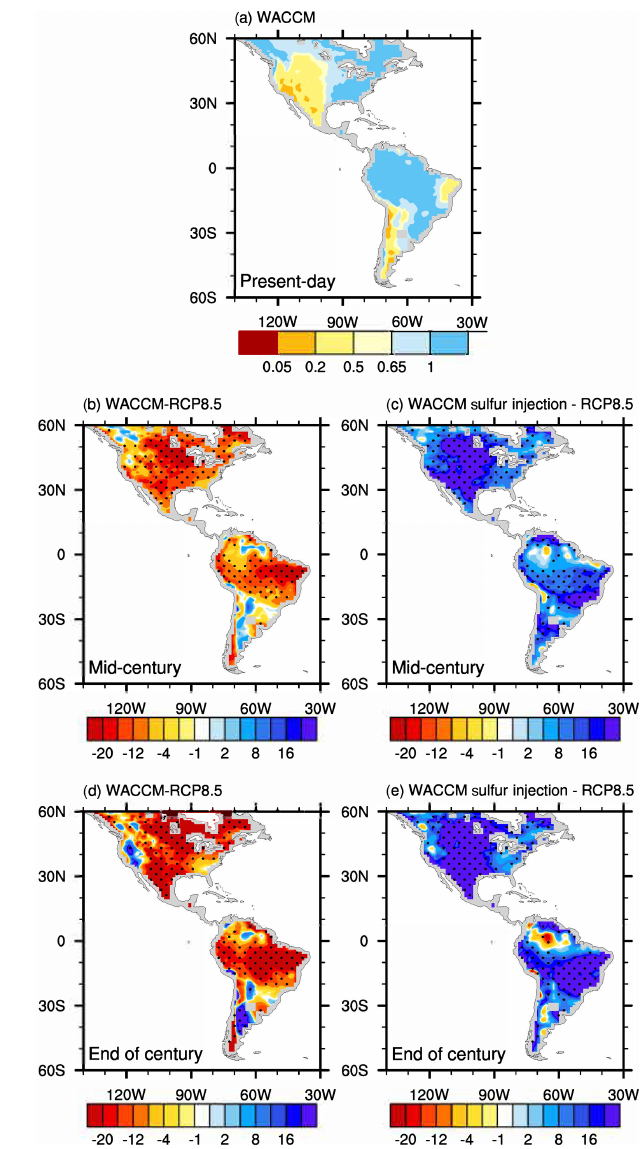
Figure 6. Same as Fig. 5, but for sulfur injection using WACCM. (a) P / PET in the bias-corrected output of the model in the present day (unitless). (b) The projected baseline changes at mid-century (%) relative to the present day; (c) the mitigation of the baseline changes relative to the present day. Panels (d, e) are the same as (b, c) but for the end of the century. The similar P / PET changes in absolute values (unitless) can be found in row 1 of Fig.